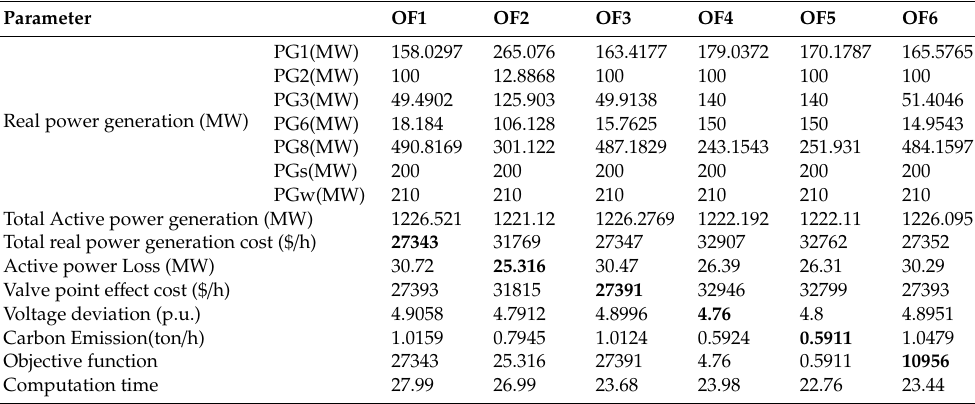
Table 5. Optimal Power flow solution without contingency using GWO.